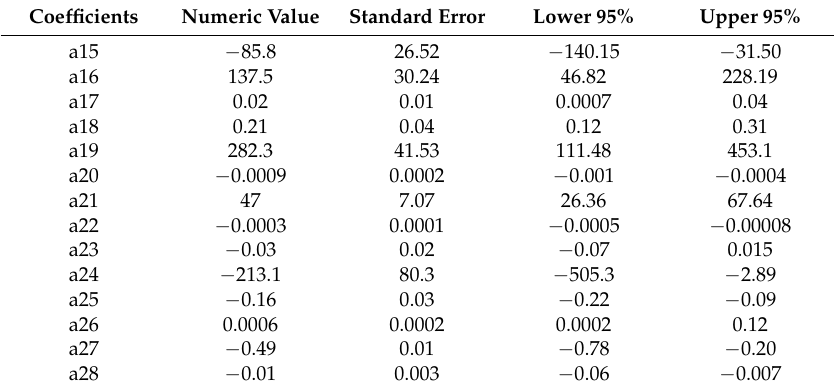
Table 4. Information for the Linear Regression Model of the RF prediction ( R 2 = 0.964; F =